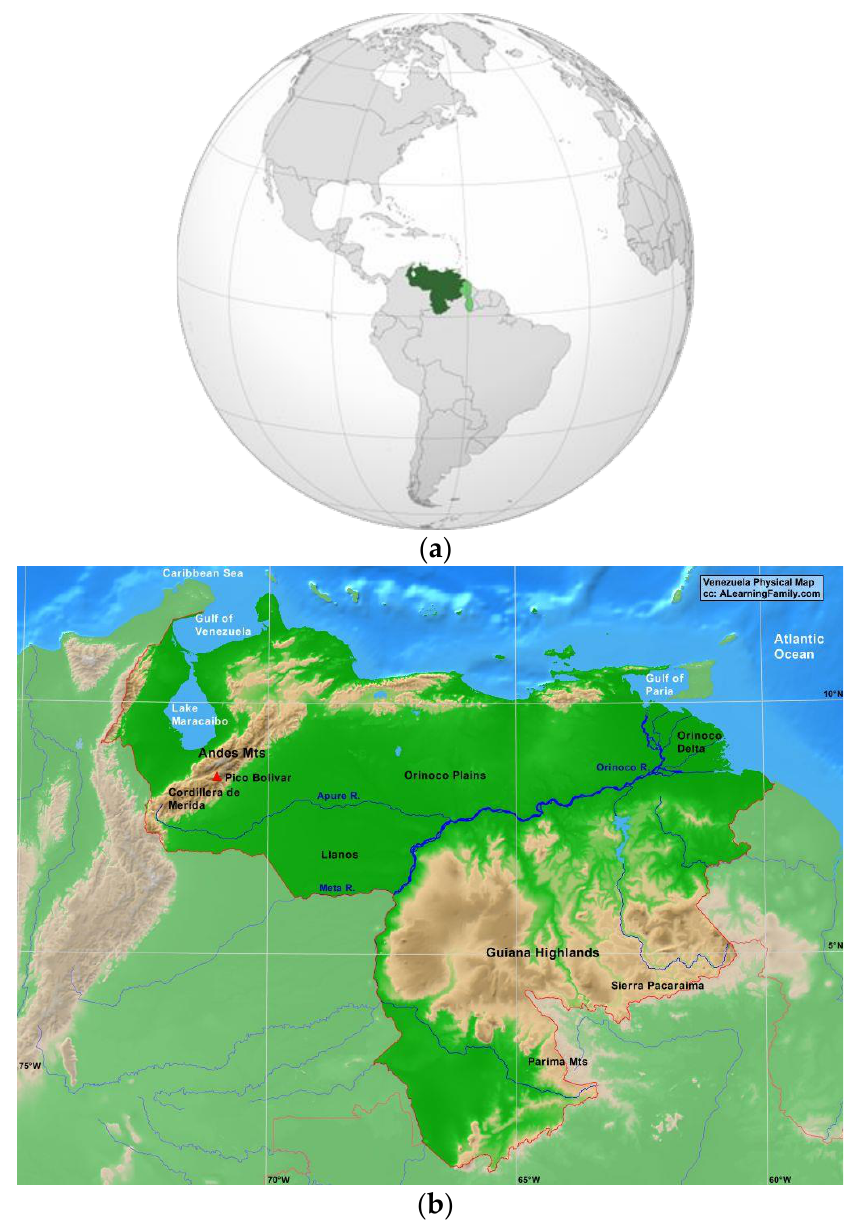
Figure 1. Study area: ( a ) Geographical location, ( b ) Elevation range with brown denoting higher terrain levels. Sources: ( a ) https://ia.wikipedia.org/wiki/Venezuela. ( b ) https://alearningfamily.com/main/venezuela-physical-map. Colors in Figure 1b are as follows: blue = rivers and water bodies; green = 0–500 meters above sea level (masl); light brown = 500–1000 masl; medium brown = 1000–2000 masl; dark brown = 2000–5000 masl (accessed on 25 March 2023).